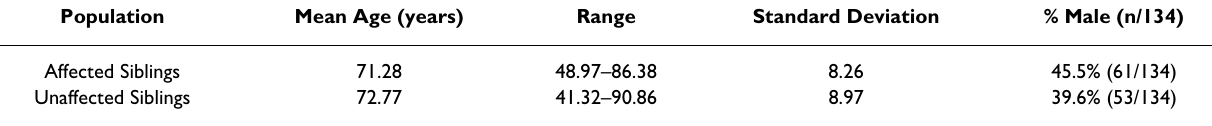
Table 4: Subject Characteristics